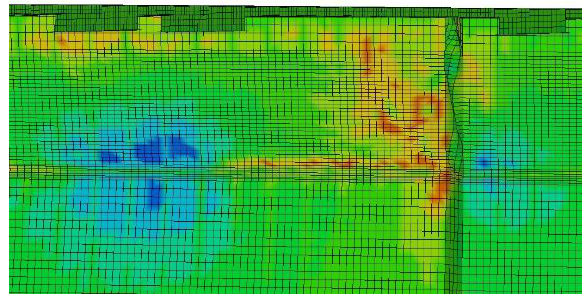
Figure 12: Pressure contour after collision at Location 3.